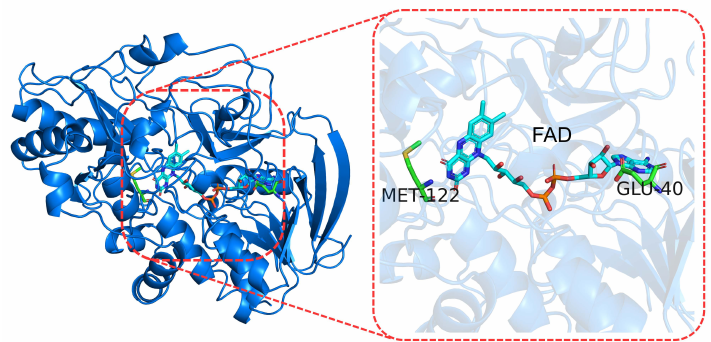
Figure 4. FAD cofactor ( right ) found in cholesterol oxidase from Streptomyces ( left